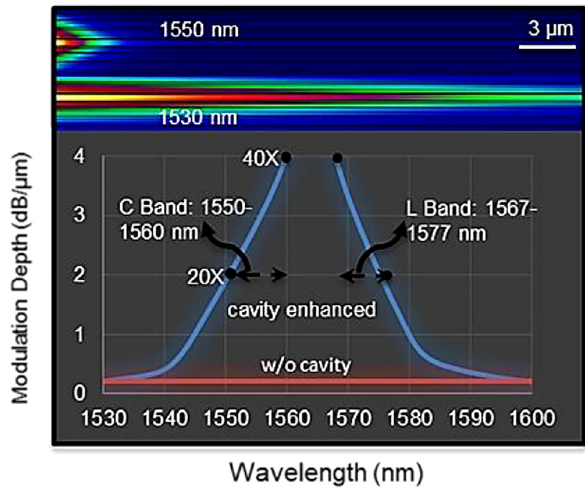
Figure 2: Estimated modulation depth as a function of input- wavelengthusingfilmmodematchingmethodofFIMMWAVEPhoton Design Corporation. Top image shows the light guide in cavity in 1530 nm and 1550 nm